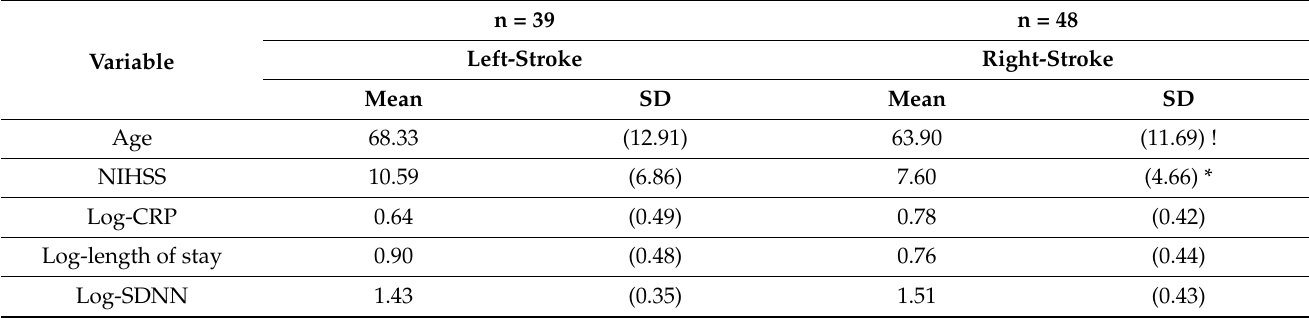
Table 1. Means (SD) for main study variables as function of stroke side.